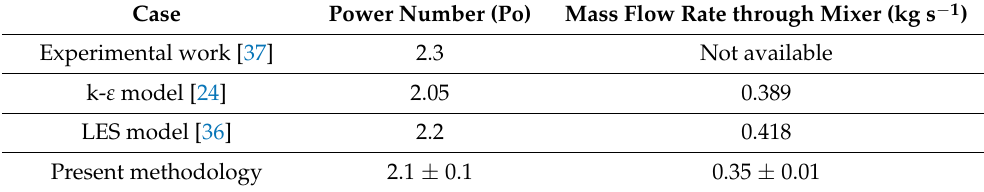
Table 3. Comparison of predicted power number and volume flow rates for an L4RT square head